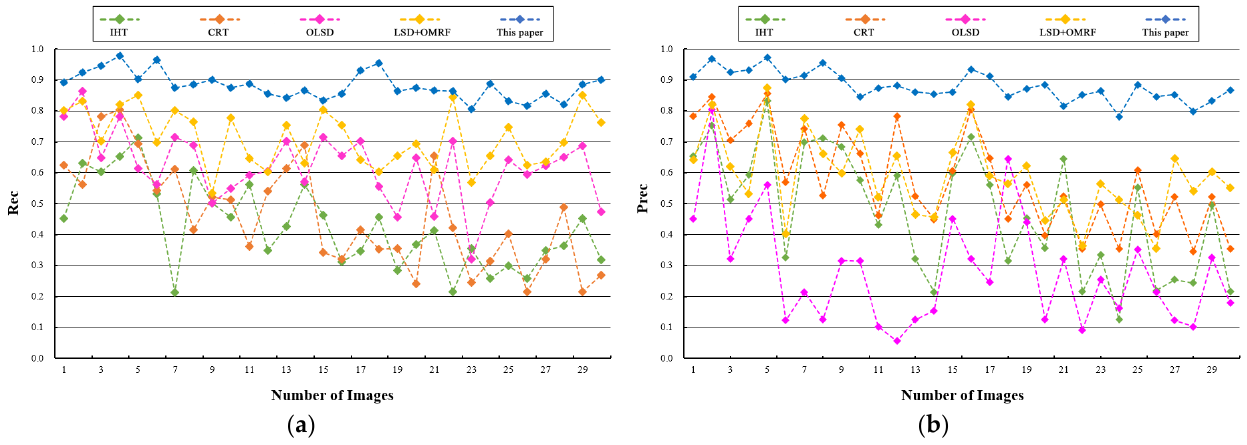
Figure 17. The Rec and Prec values for different IC images. Abscissa values of 1–10 in the figures denote low IC images, 11–20 are medium IC images, and 21–30 are high IC images. ( a ) The Rec of test images; ( b ) The Prec of test images. Table 2. The mean Rec and Prec of test images.